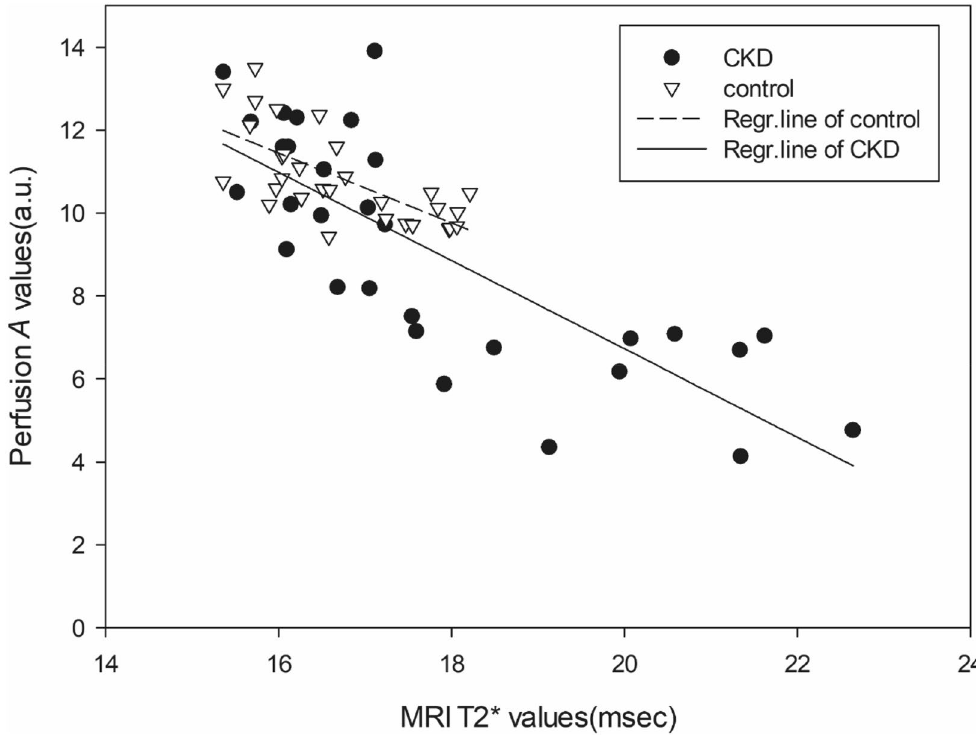
Figure 3. The correlation of perfusion parameter A (a.u.) and MRI-T2* value (msec) in control rats (inverted triangles) and CKD rats (black circles). All symbols represent measurements made in the right knee joint. Correlations between perfusion parameter A values and MRI-T2* values in the IPFP were significantly negative in the control and CKD groups ( p < 0.001). The CKD group, compared to control group, had a higher negative correlation coefficient (ρ = − 0.815) between perfusion parameter A and MRI-T2* ( p <